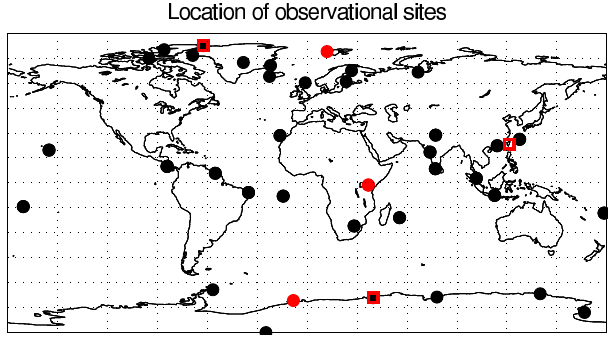
Figure 1. Location of all stations used in this paper. O 3 sondes are indicated as filled black circles. The ones selected for a more detailed discussion have been marked in red: Ny-Ålesund (79 ◦ N, 12 ◦ E) in the Arctic, Nairobi (1.27 ◦ S, 36.8 ◦ E) in the tropics, and Neumayer (70.65 ◦ S, 8.25 ◦ W) in the Antarctic. The three sites se- lected for the total ozone column (TOC) discussion are indicated by the red